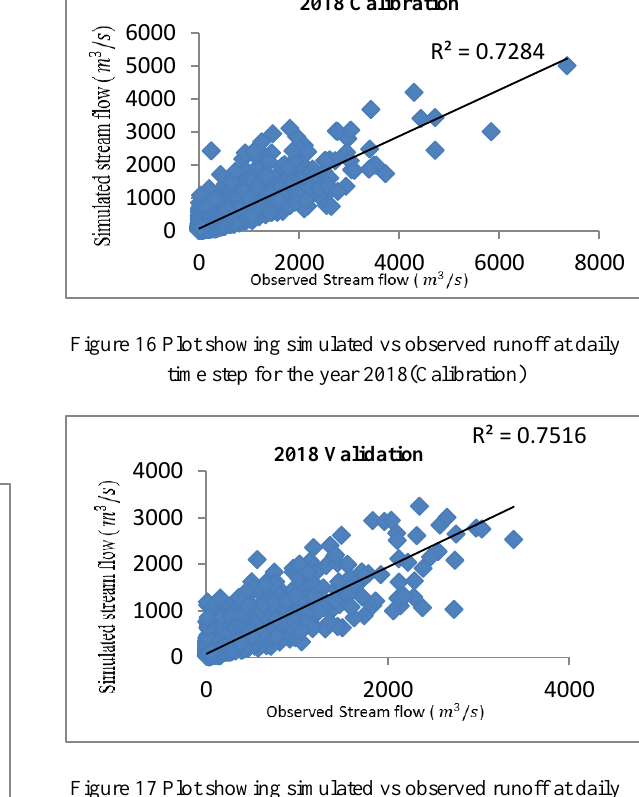
Figure 17 Plot showing simulated vs observed runoff at daily time step for the year 2018 (Validation) Line graphs indicated that simulated values are underpredicted when compared to the observed runoff in most of the cases during the calibration period and are overpredicted during validation phase at daily time steps. The simulated runoff correctly depicted the peaks and base flow at monthly time steps.